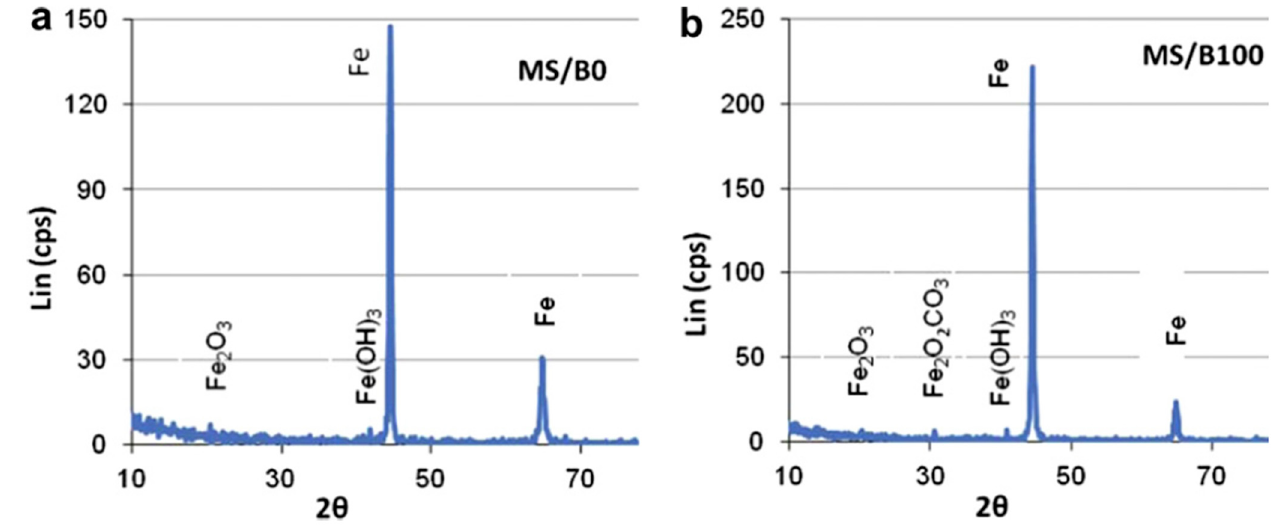
Figure 13. Corrosion products formed on MS upon exposure to diesel and biodiesel [67].